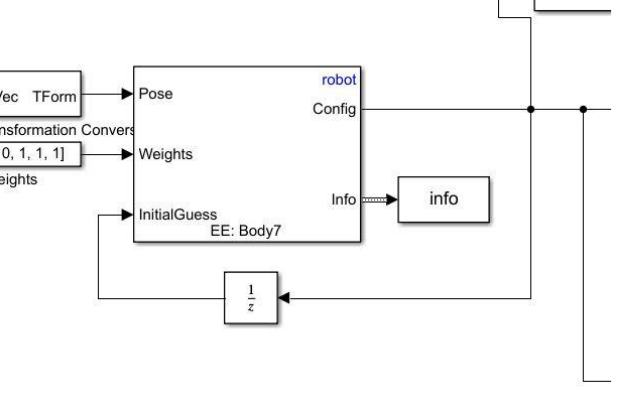
Figure 6. Inverse kinematics Block in MATLAB